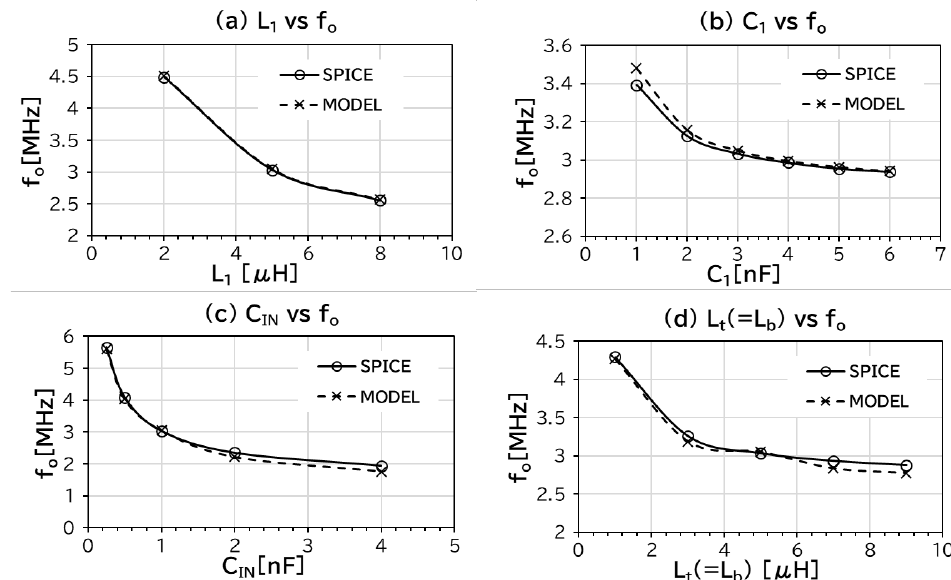
Figure 7. Operation frequency as a function of each circuit parameter. ( a ) L 1 vs fo, ( b ) C 1 vs fo, ( c ) C IN vs fo, ( d ) L t (=L b ) vs fo. ( c ) C IN vs. fo, ( d ) L t (=L b ) vs.